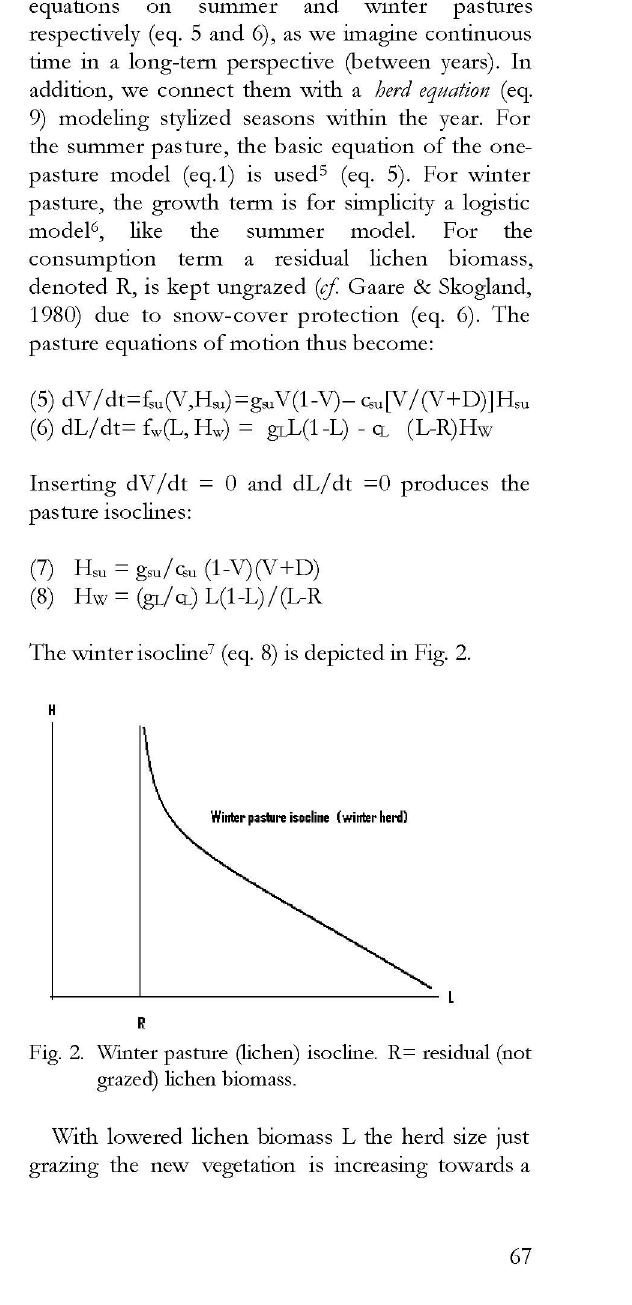
Fig. 2. Winter pasture (lichen) isocline. R= residual (not grazed) lichen